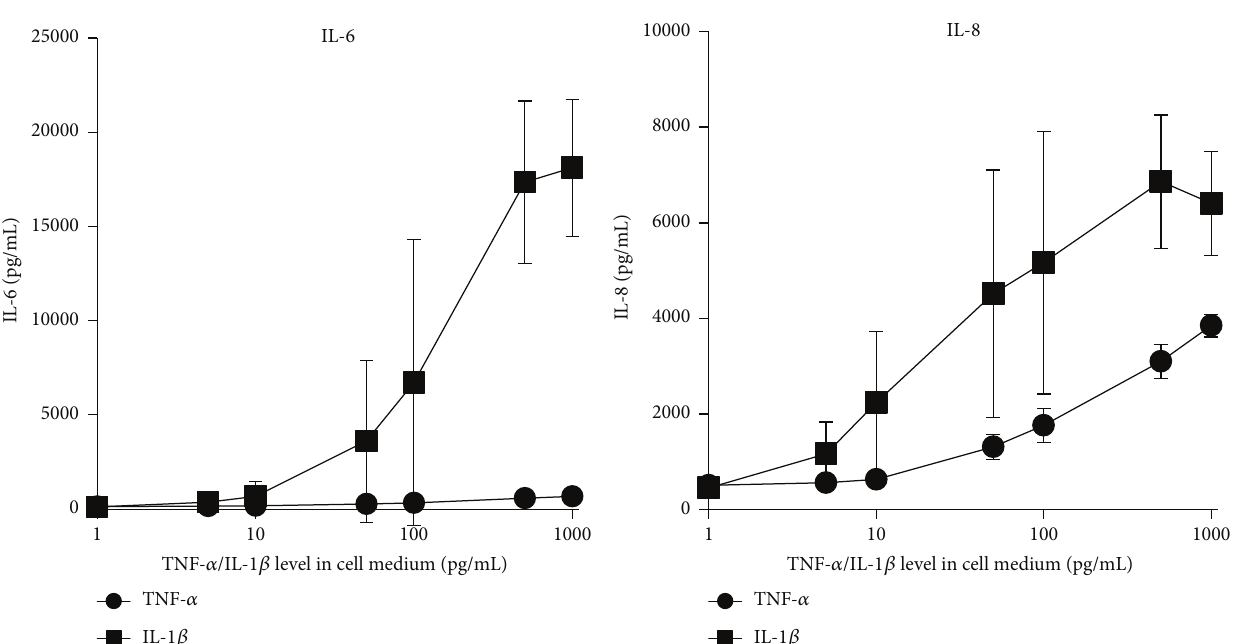
Figure 7: TNF- 𝛼 or IL-1 𝛽 dose-dependent production of IL-6 and IL-8 by HUVEC. IL-6 and IL-8 secretion by HUVEC after 16-hour incubation in cell media with 10% of plasma spiked with increasing amounts of TNF- 𝛼 or IL-1 𝛽 (mean ± SD, 𝑛 = 3